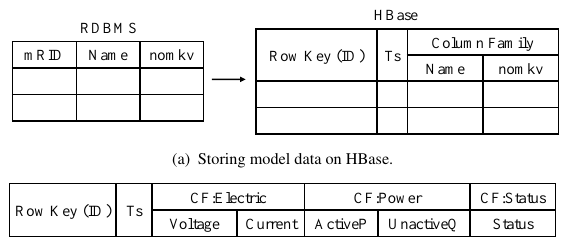
Fig. 5 Process of generating runtime data.